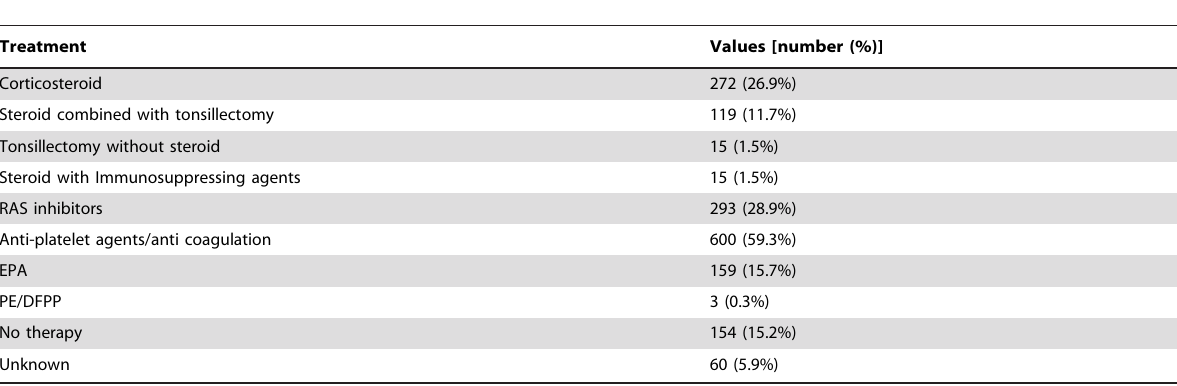
Table 3. Initial treatment of individual patients.